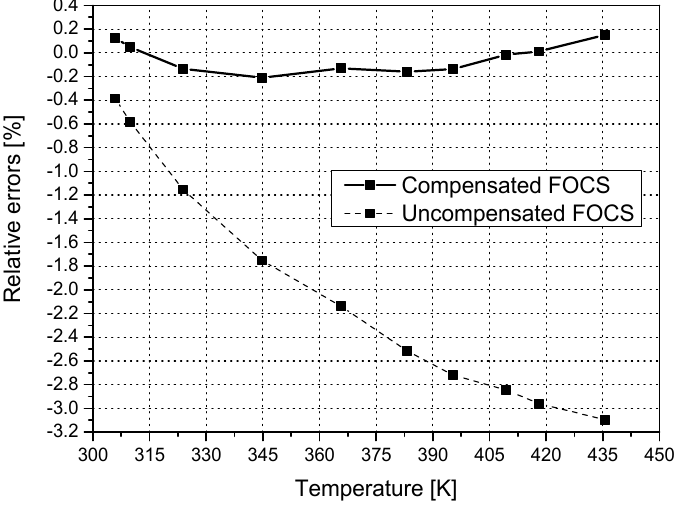
Figure 5. Comparison of relative errors of the uncompensated and compensated FOCS.